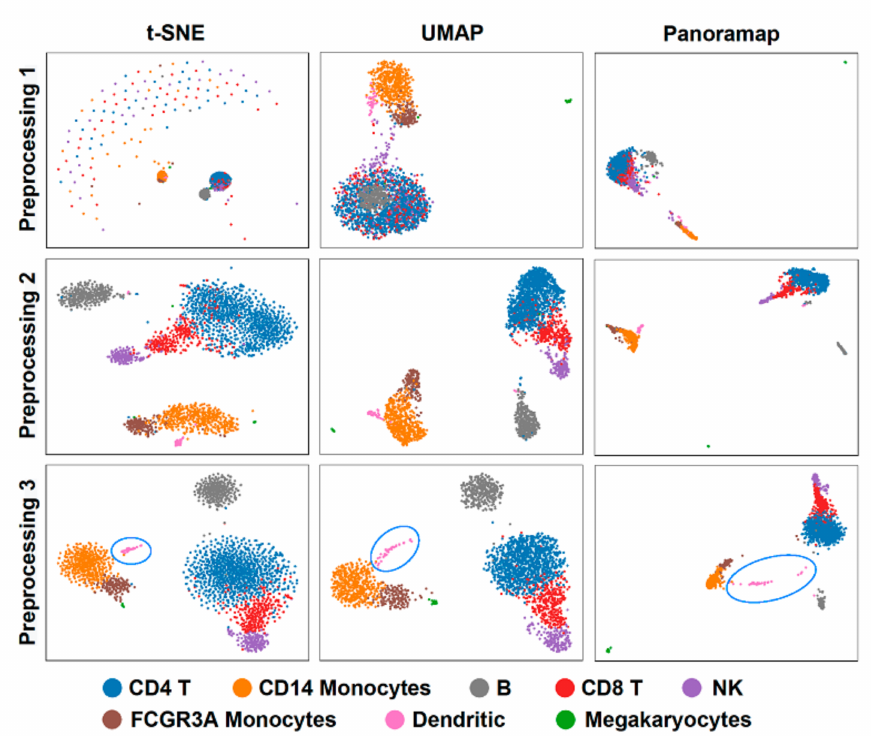
Figure 3. Panoramap is stable and robust to preprocessing methods. t-SNE and UMAP may have artefacts or violate topological structures. Preprocessing 1: normalization + logarithm. Preprocessing 2: normalization + logarithm + PCA. Preprocessing 3: normalization + logarithm + selection of highly variable genes + scale + PCA. The blue circles highlight the dendritic cells in Preprocessing